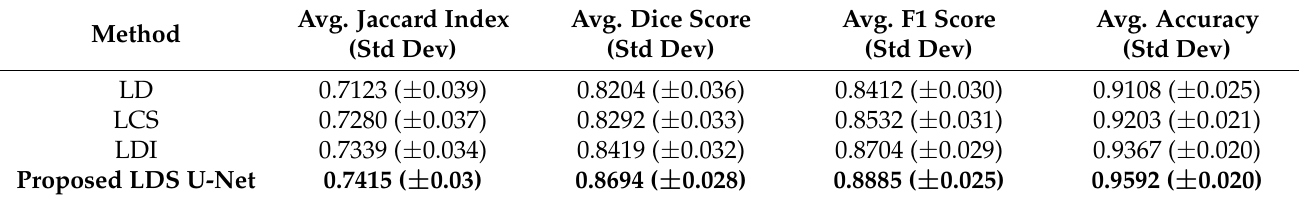
Table 1. Quantitative evaluation of ablation